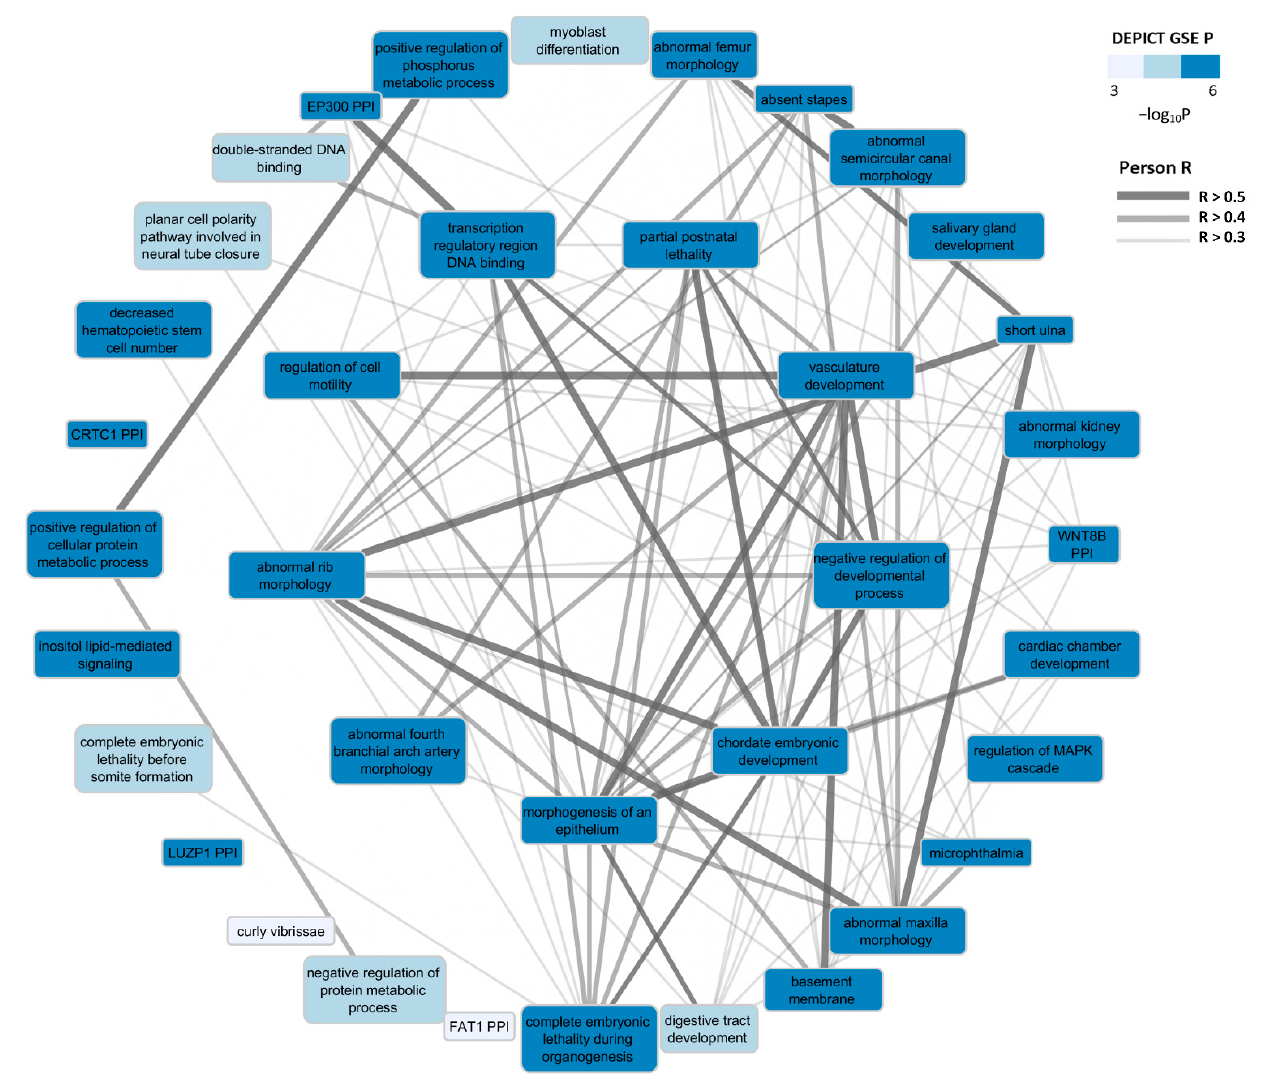
Figure 4. DEPICT network plot: nodes represent enriched gene sets (FDR < 0.05) and links represent pairwise Pearson correlation coefficient (r) between gene sets. Only cluster centers from affinity- propagation clustering and only links with r > 0.3 are shown. The inner layer contains pathways with centrality degree ≥ 26, i.e., the 4th quartile of all gene sets, meaning the largest number of connections which imply their importance in network survival.